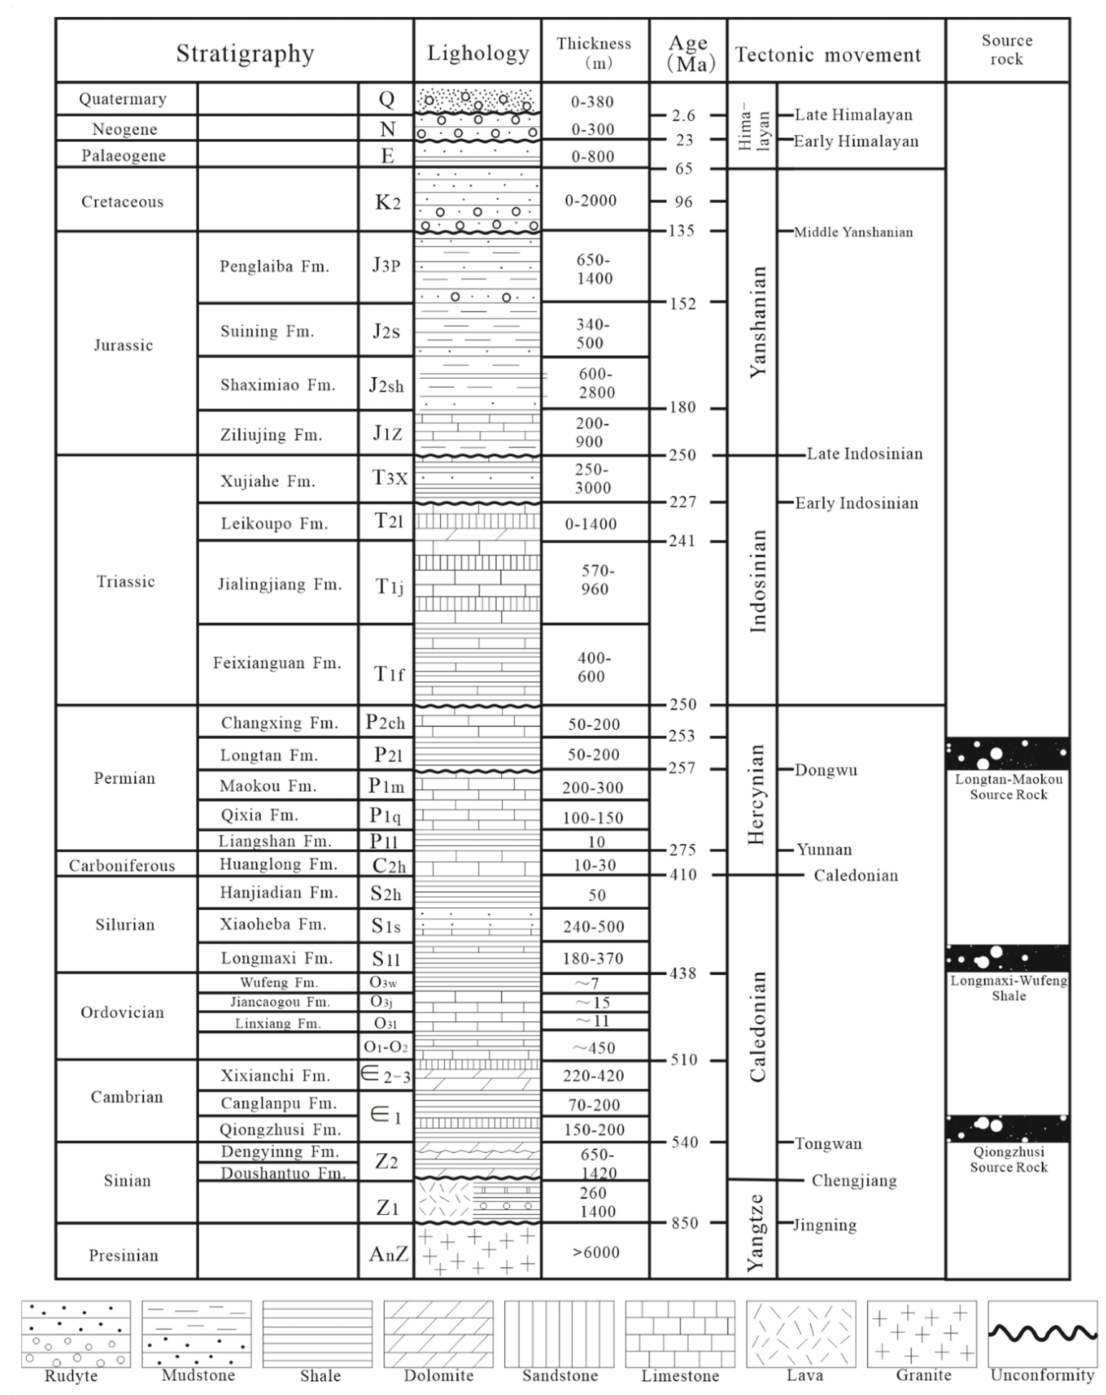
Figure 2. Schematic diagram showing the stratigraphy system of the Sichuan Basin, as well as the main tectonic